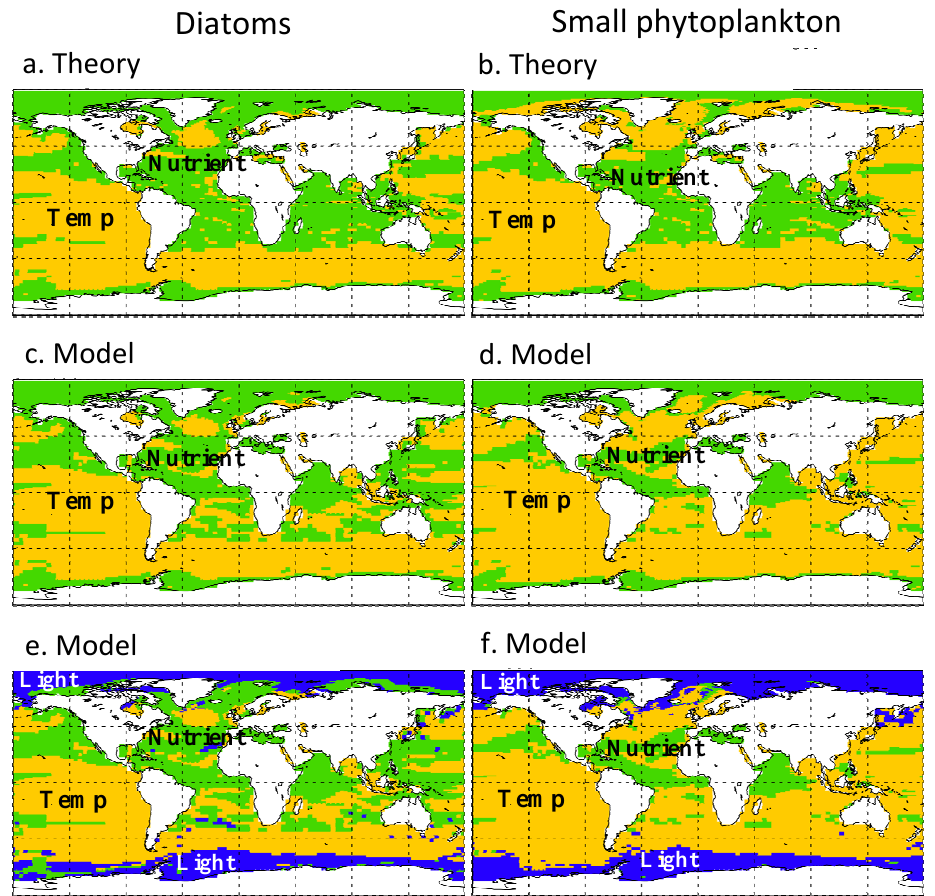
Fig. 11. (a–b) : Theoretical prediction based on Eq. (21) of whether the 1980–2100 growth rate change due to nutrient limitation should be larger than the growth rate change due to temperature. Prediction shown for (a) diatoms and (b) small phytoplankton. Green: growth rate change due to nutrient (either nitrate or iron) dominates; Yellow: growth rate change due to temperature dominates. (c–f) Model Results : (c–d) : regions where the model calculated 1980–2100 growth rate trend due to nutrient limitation is larger (green) or smaller (yellow) than the growth rate change due to temperature for diatoms (c) and small phytoplankton (d). (e–f) Shows regions where the model calculated 1980–2100 growth rate trend is dominated by either the nutrient (green), temperature (yellow) or by the light (blue) contributions (Eqs.